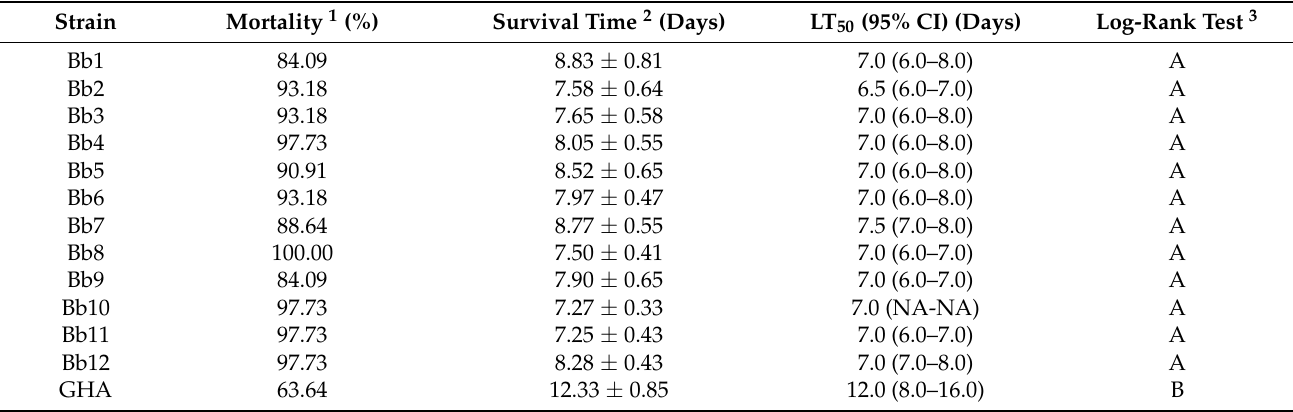
1 Percent of dead individuals at the end of experiment corrected for mortality in control using Abbott equation [48]. 2 The mean survival time and its standard error were underestimated because the largest observation was censored and the estimation was restricted to the largest event time. 3 Different letters indicate a statistically significant difference between lines ( p values adjusted for multiple comparisons by Šid á